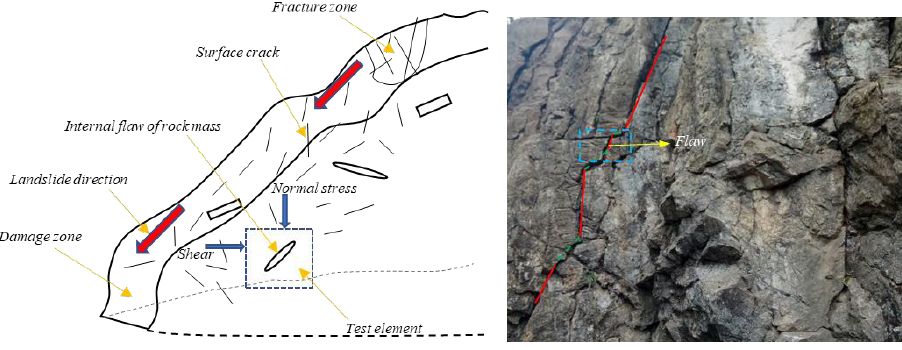
Figure 1. Stress diagram of high defect rock slope.